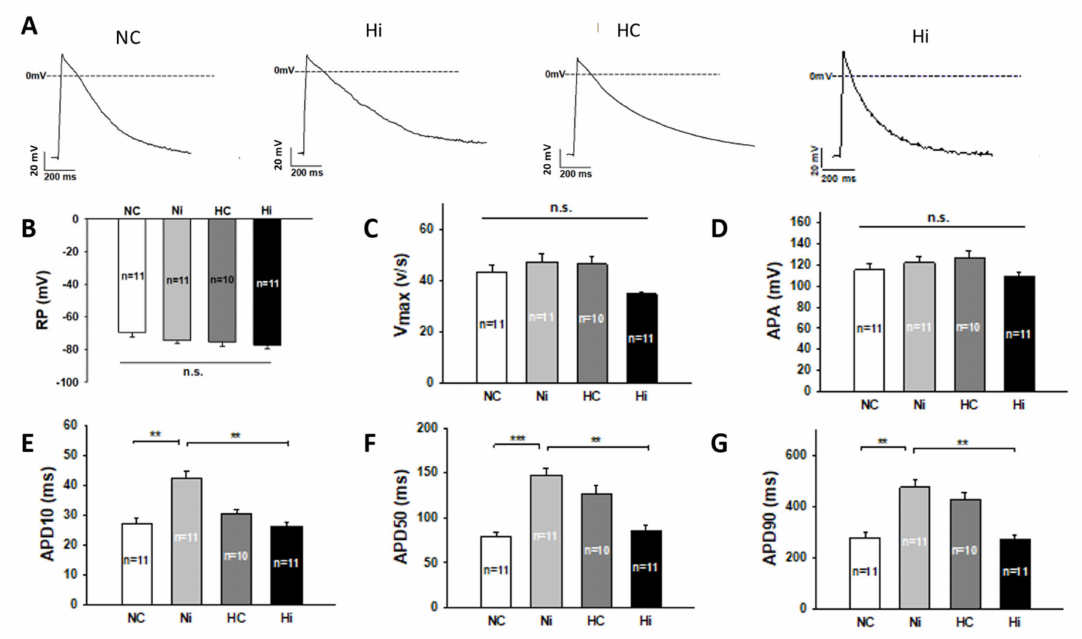
Figure 1. High level of glucose counteracted the effects of high-concentration isoprenaline on action potentials. “NC” represents data from hiPSC-CMs treated with normal level of glucose (5.5 mM). “Ni” represents data from hiPSC-CMs treated with normal level of glucose and high concentration (1 mM for 1 h) of Iso. “HC” represents data from hiPSC-CMs treated with high level (22 mM for 14 days) of glucose. “Hi” represents data from hiPSC-CMs treated with a high level of glucose and a high concentration of Iso. Action potentials (AP) were recorded at 1 Hz stimulation. ( A ) Representative traces of APs in different groups. ( B ) Mean values of resting potentials (RP). ( C ) Mean values of maximal depolarization velocity of AP (Vmax). ( D ) Mean values of action potential amplitude